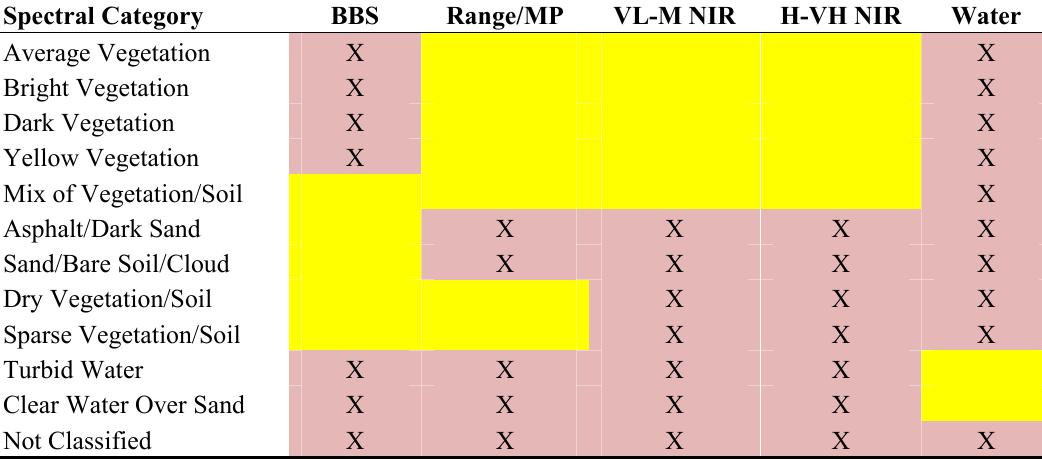
Table 10. ATCOR™-SPECL pre-classification of the SPOT test image. OAMTRX instance between test classes (refer to Table 2) and reference classes (refer to Table 6), represented as table rows and columns respectively. For the sake of simplicity, only test classes (table rows) whose occurrence is greater than 0.15% in the test map being investigated are shown. “Correct” entries selected by the present authors for inter-vocabulary reconciliation are shown as yellow checkmarks.